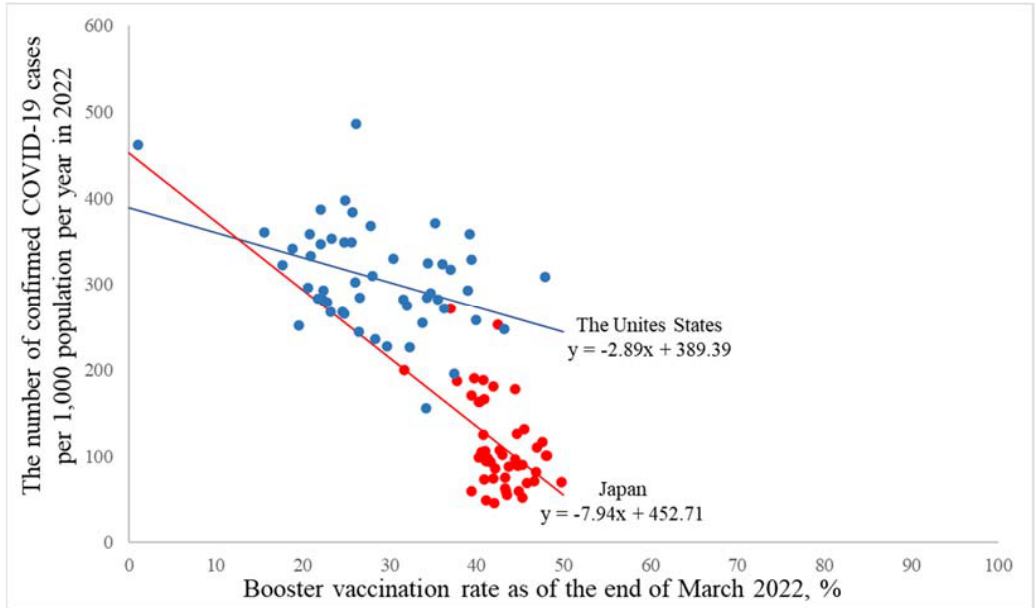
Figure 4. A macro-level association of booster vaccination rate with the number of confirmed COVID-19 cases per year based on the jurisdictions in the United States and Japan. Blue dots are jurisdictions in the United States, and red dots are jurisdictions in Japan. The line shows the slope based on the generalized regression model as an approximated curve. The covariate was not included in this model.